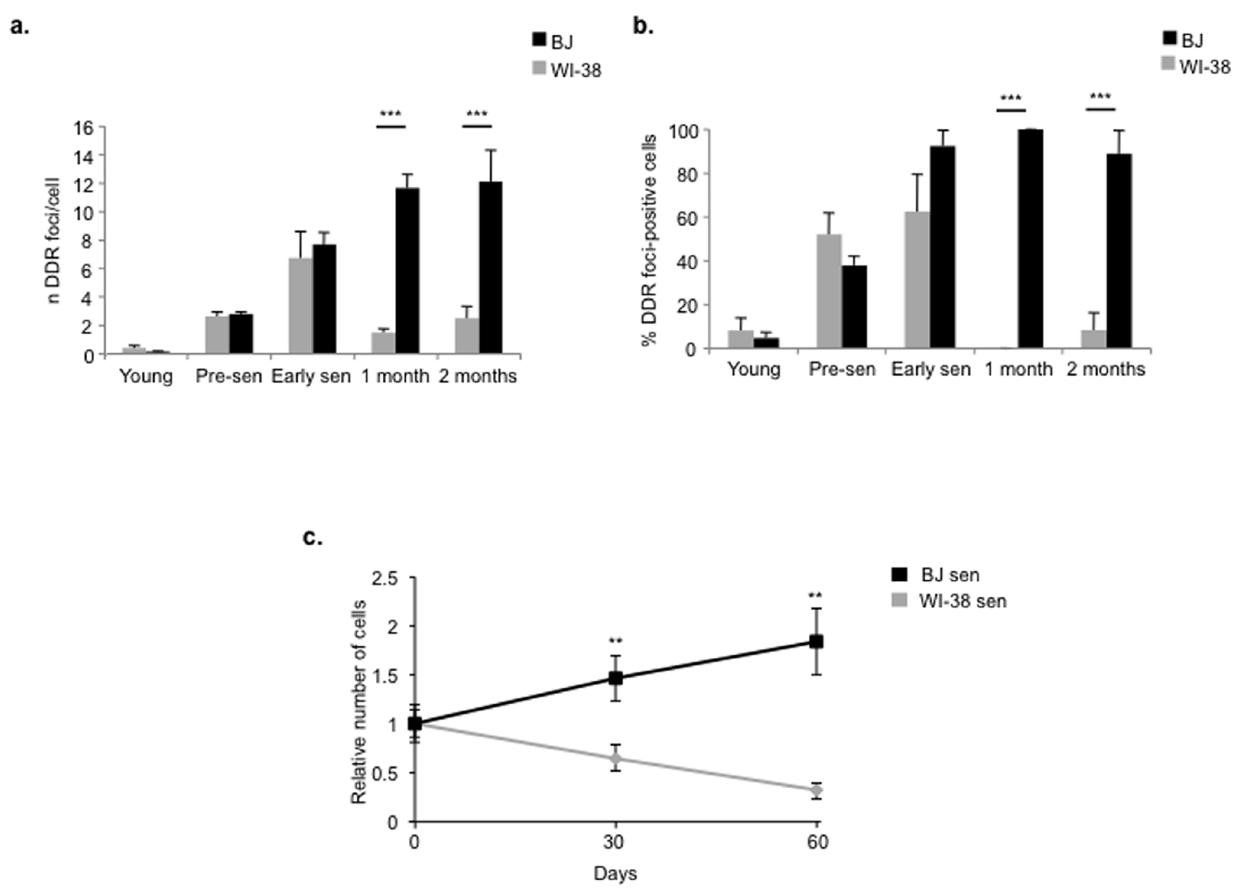
Figure 3. Unstable cellular senescent state is associated with loss of DDR foci. a. Bar graphs show the average number of c H2AX foci 6 s.e.m. per cell before (young and pre-sen) and at the indicated time points after senescence establishment in two different types of fibroblast cell strains, BJ and WI-38. b. Bar graphs show the fraction of c H2AX foci-positive cells 6 s.e.m. at the indicated time points after senescence establishment in BJ vs WI-38. Cells were considered foci-positive if the number of foci were more than three (*** p-value , 0.001). c. WI-38 senescent cells (WI-38 sen) in culture tend to reduce in number with time (day 30 and day 60) whereas BJ senescent cells (BJ sen) do not. The graph shows the fold change in cell number 6 s.d. normalized to the number of senescent cells plated at day 0 (** p-value ,